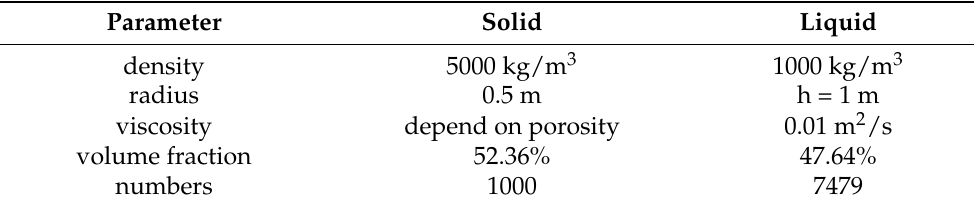
Table 2. Parameters of particles in the case of a liquid flowing through a porous media case.